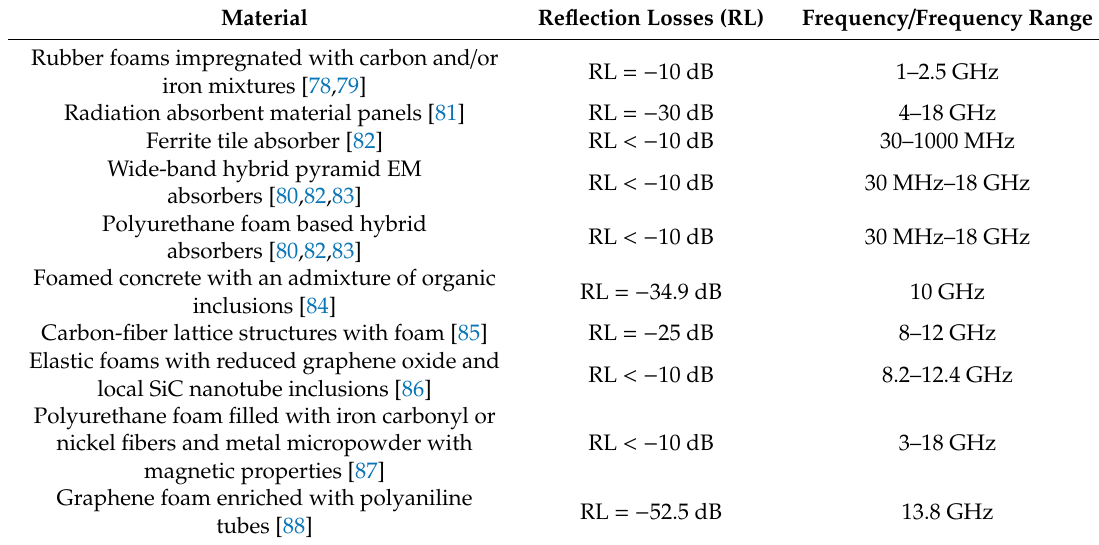
Table 8. Reflection losses of hybrid structured